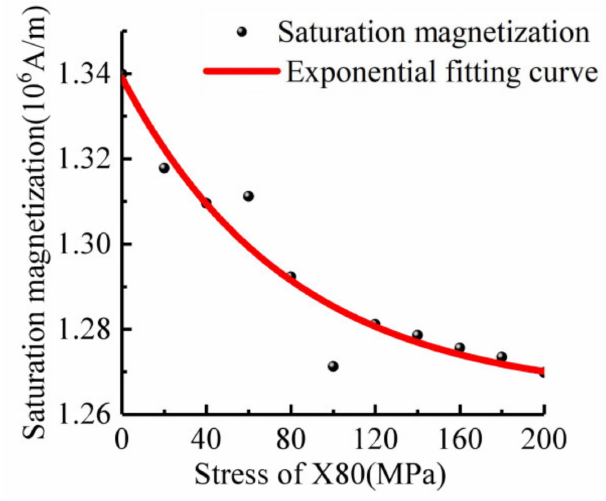
Figure 5. X80 Curve of saturation magnetization with